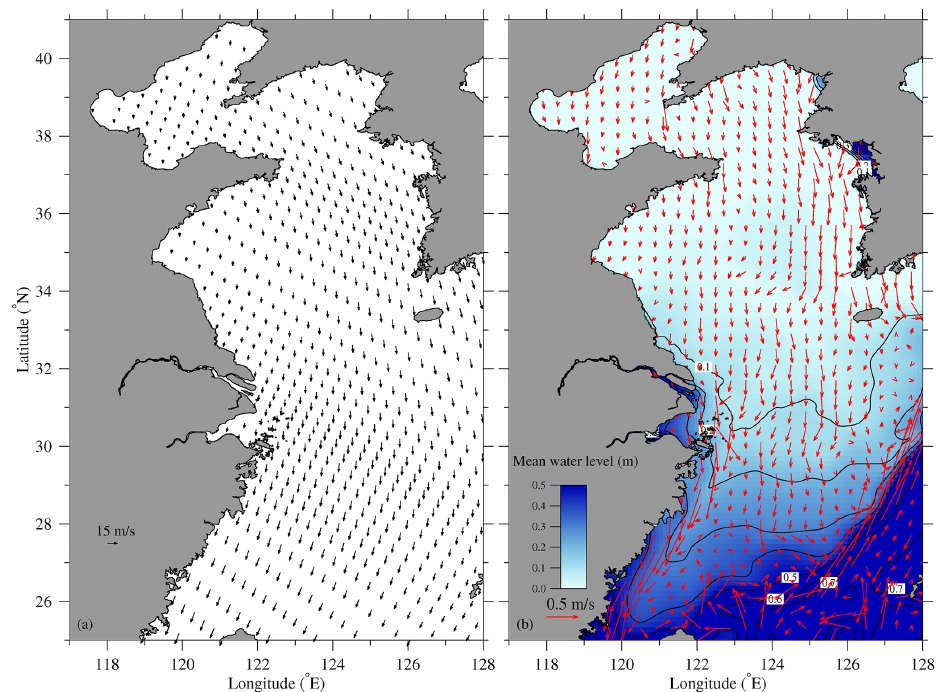
Figure 5. Distributions of the climatic wind field (a) and residual (mean) water level and surface current (b) in February 2014.